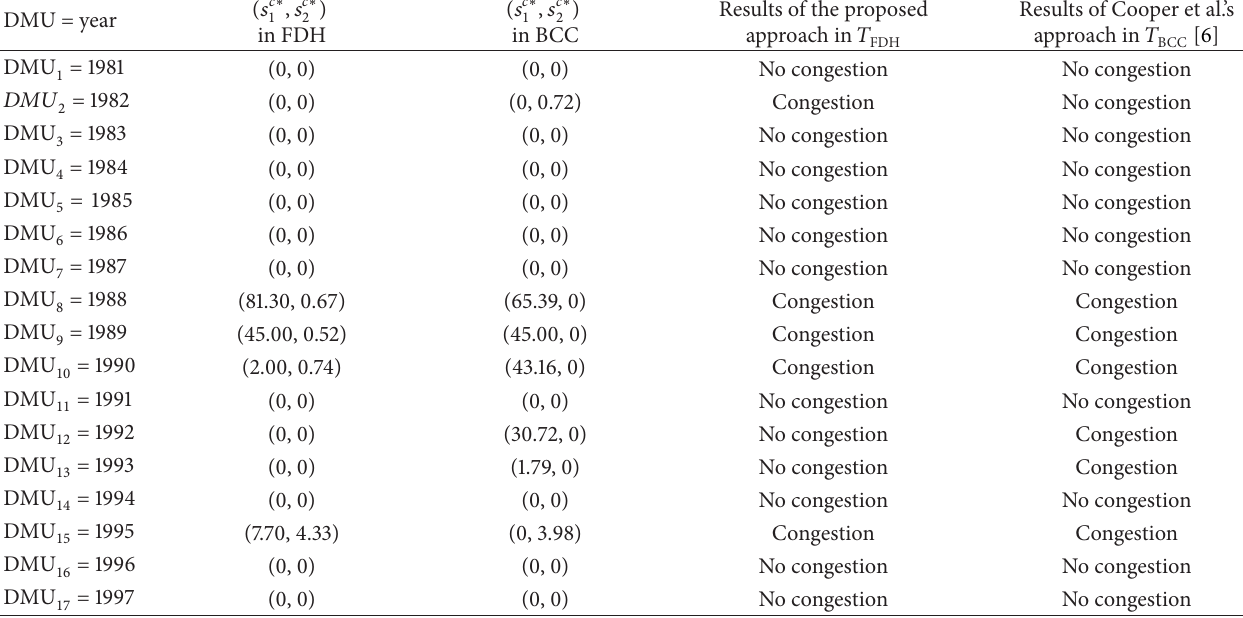
Table 6: Comparison results of congestion treatment in BCC and FDH technologies in Example 3.